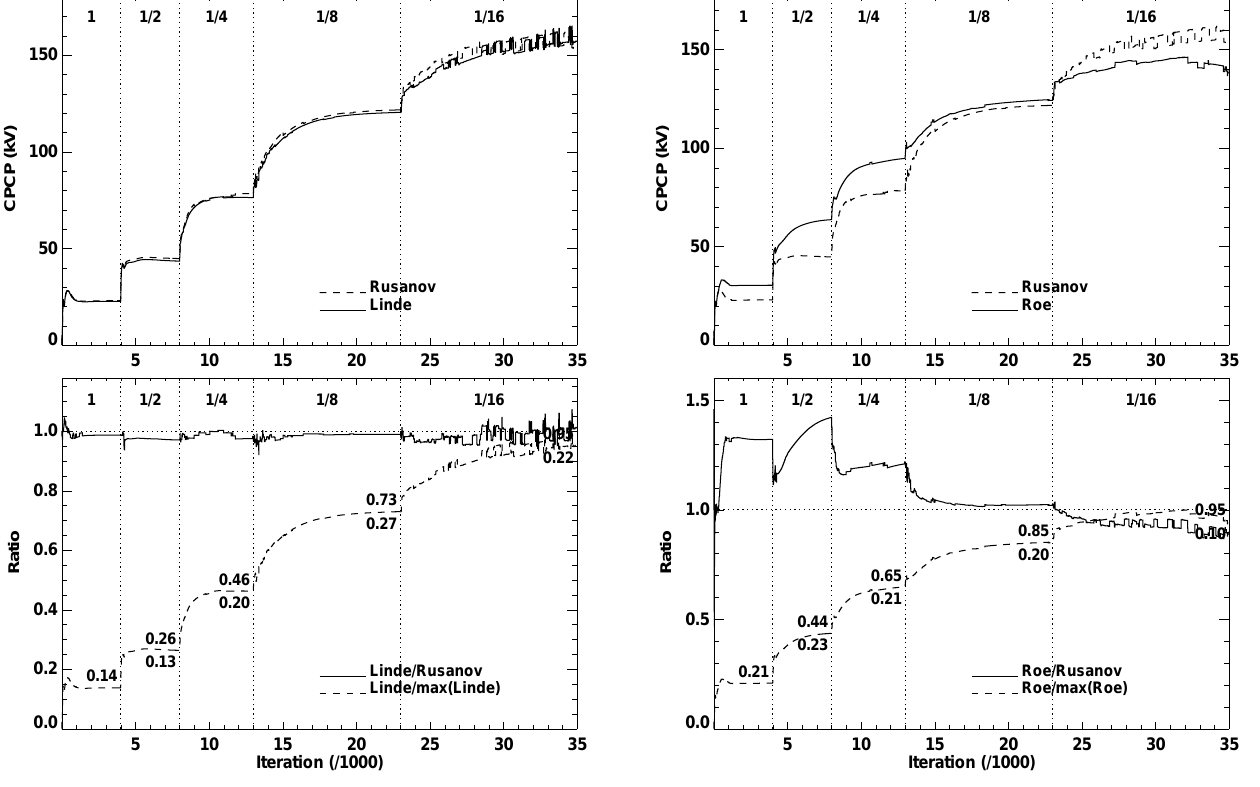
Fig. 4. The top figure shows the ionospheric cross polar cap po- tential as a function of run-time, with Rusanov (dashed) and Linde (solid) second-order solvers. The smallest grid cell size (in R E ) is indicated above the solid line. The bottom figure shows the ra- tio between the Linde and Rusanov cross polar cap potentials as a function of run-time, and the percentage of the final CPCP for the Linde scheme as a dashed line.